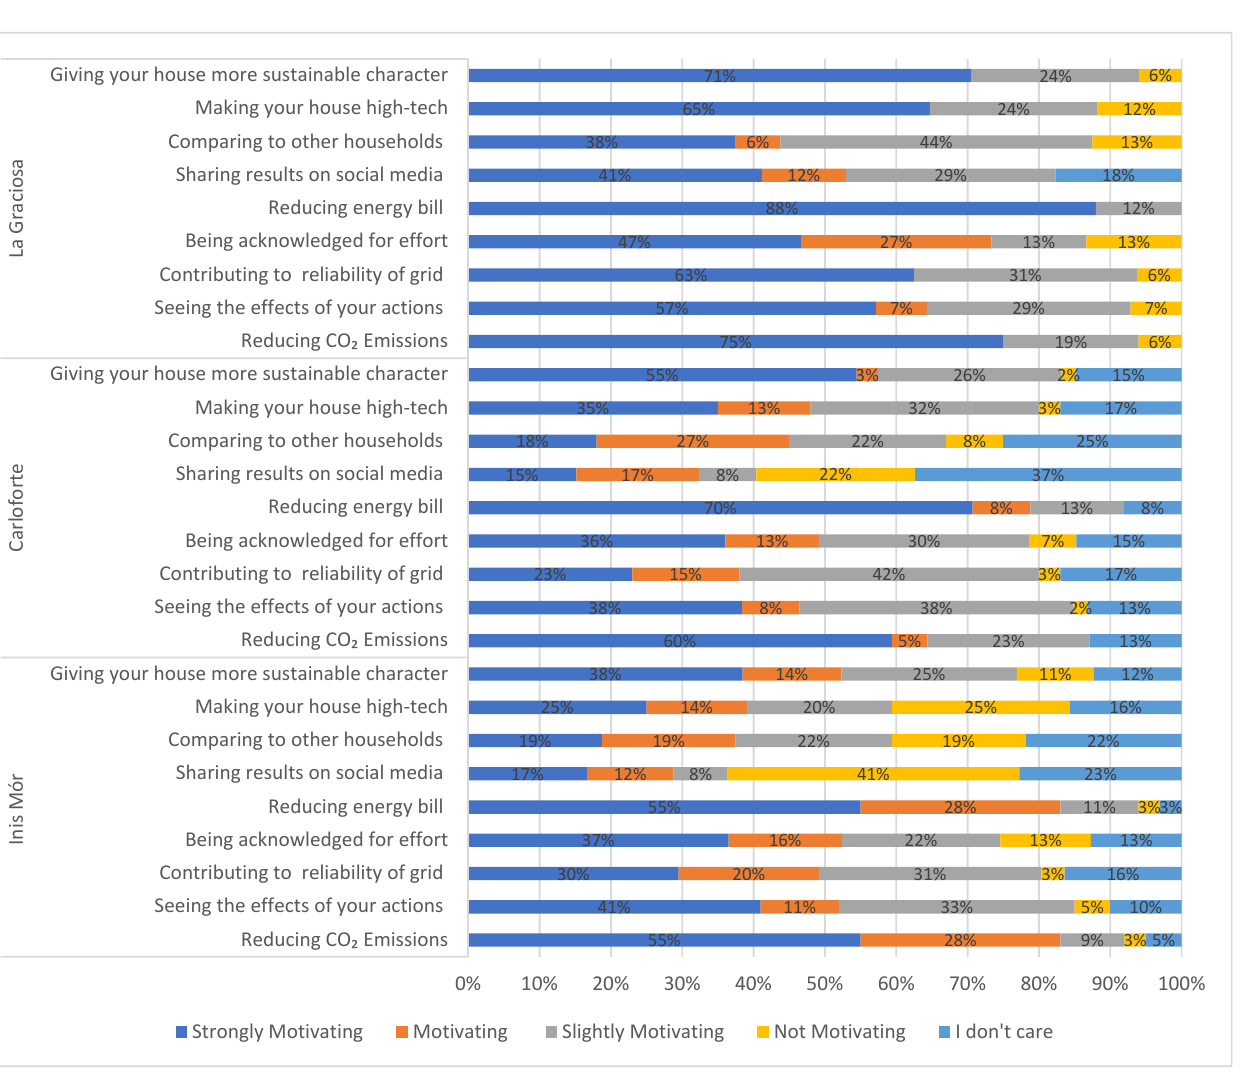
Figure 3. Motivating factors for the uptake of DR technologies.